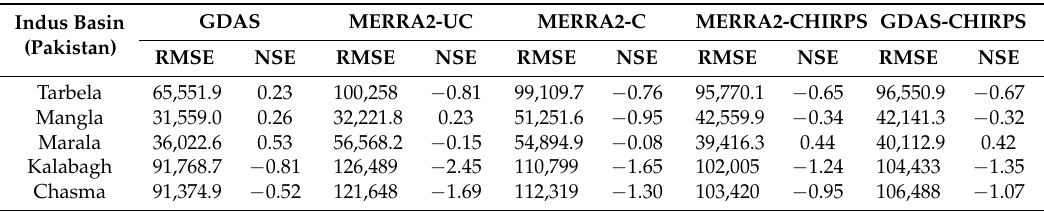
Table 2. The root mean square error and the Nash-Sutcliffe efficiency coefficient between the model and the observed daily streamflow in 2014 over the Indus river basin (see Figure 4 and Table 1 for details about location and simulation).